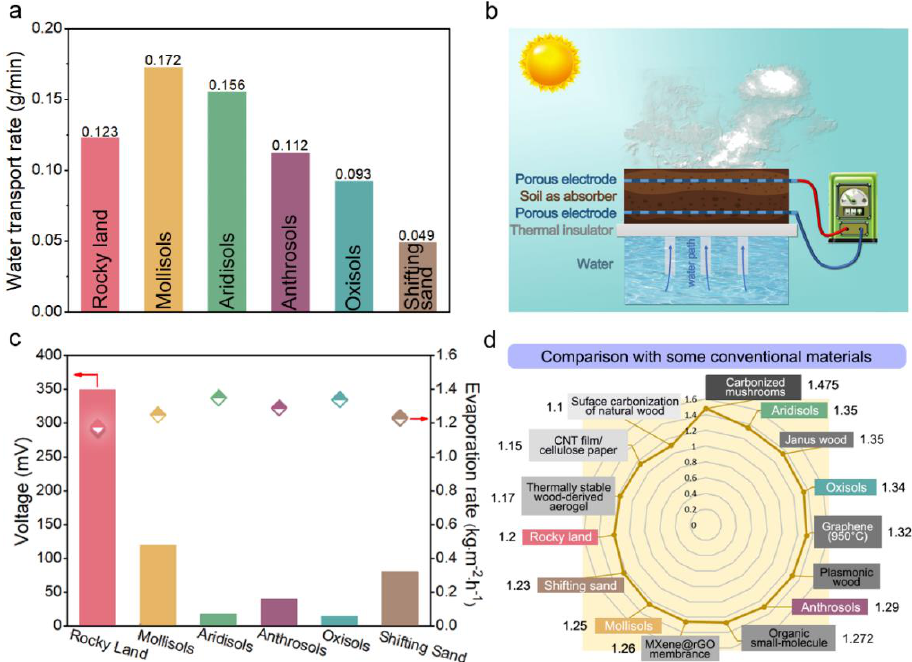
Figure 2. ( a ) Water transport rates in the six soils; ( b ) Structure of ISUM for solar desalination and electricity generation; ( c ) Comparison of induced voltage and water evaporation rate for the six soils (the bars represent voltage and the diamonds represent evaporation rate; the left arrow refers to bars and the right arrow refer to the diamonds); ( d ) Comparison of water evaporation rates of some typical carbon-based materials under the same sun irradiation.